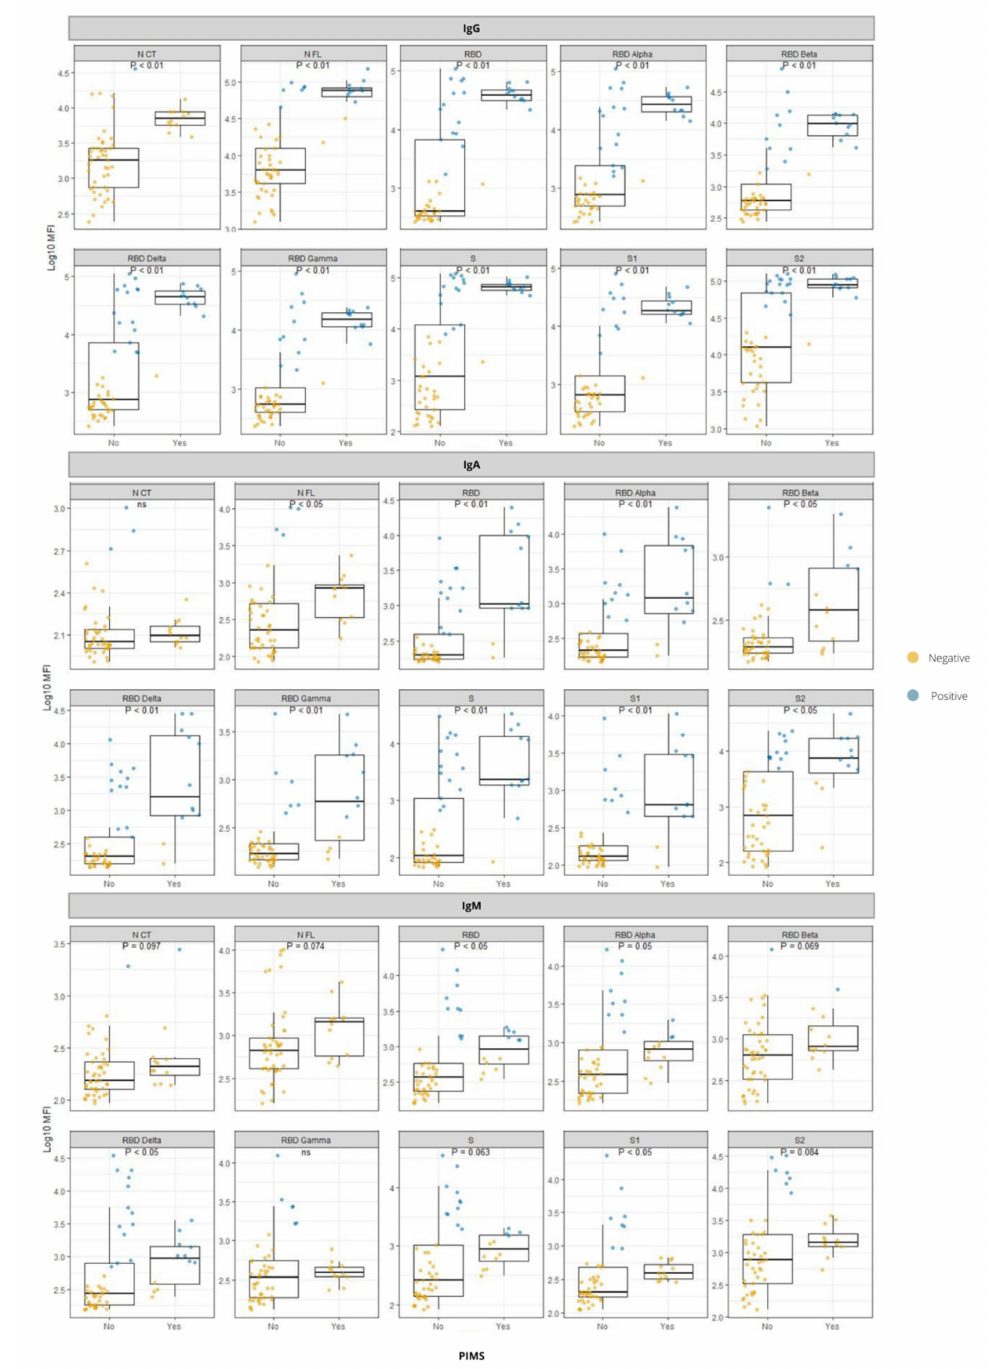
Figure 2. Comparison of antibody responses against different SARS-CoV-2 antigens between children with PIMS-TS and children who did not develop PIMS-TS. IgG, IgA, and IgM isotypes to different antigens tested: N CT (C-terminal region of Nucleocapsid), N FL (full-length Nucleocapsid), RBD (receptor binding domain of spike), S (full-length Spike protein), S1 (subunit 1 from S), S2 (subunit 2 from S), all from Wuhan, and RBD from VoCs: RBD Alpha, RBD Beta, RBD Delta, RBD Gamma. Dots represent each individual value, the blue color indicates a seropositive participant, and the orange color shows a seronegative participant. Groups were compared using the Wilcoxon rank-sum